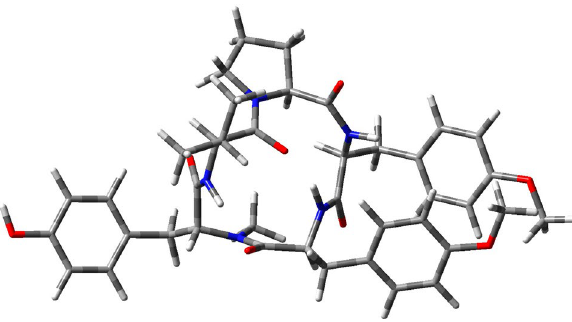
Figure 4. Optimized molecular structure of Aspergillipeptide